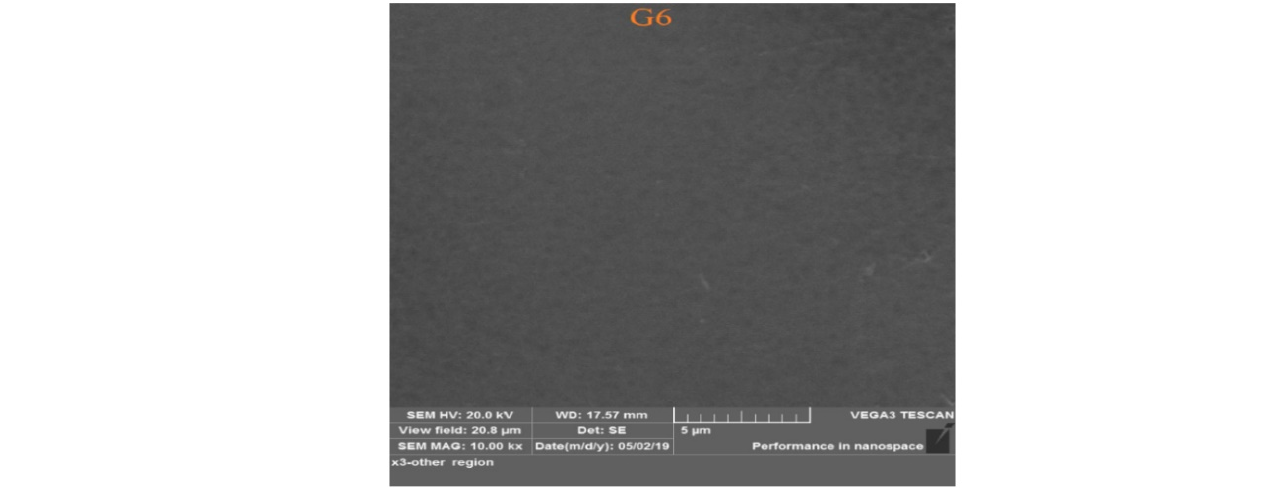
Figure 7. Top surface structures SEM images of the neat and PES/TGF membranes with various TGF nano-polymer contents (( G0 ) 20/0, ( G1 ) 20/1, ( G2 ) 20/2, ( G3 ) 20/3, ( G4 ) 20/4, ( G5 ) 20/5, ( G6 )